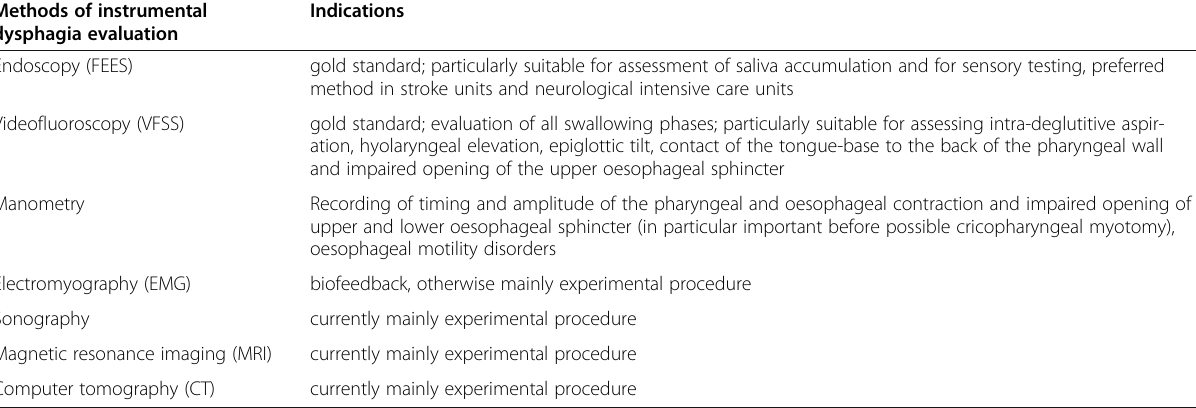
Table 1 Differential indication of instrumental dysphagia diagnostics for the evaluation of neurogenic dysphagia [65] Methods of instrumental dysphagia evaluation